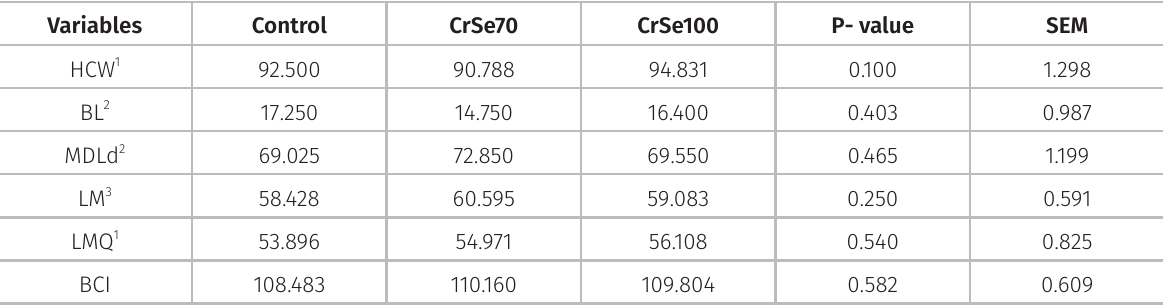
Table III. Carcass characteristics of swine supplemented with organic chromium and selenium from 70 to 130 kg body